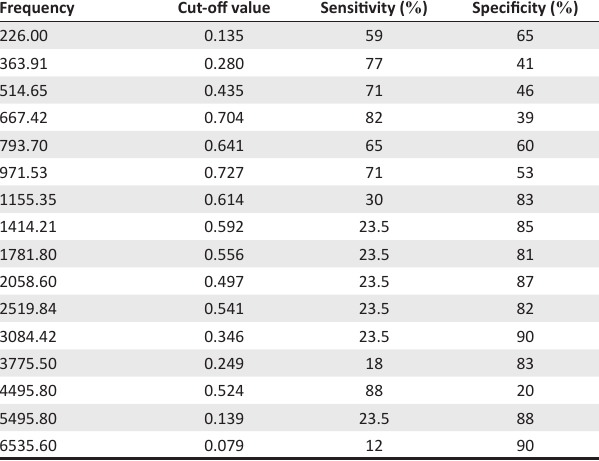
TABLE 4 : The sensitivity and specificity of wideband absorbance